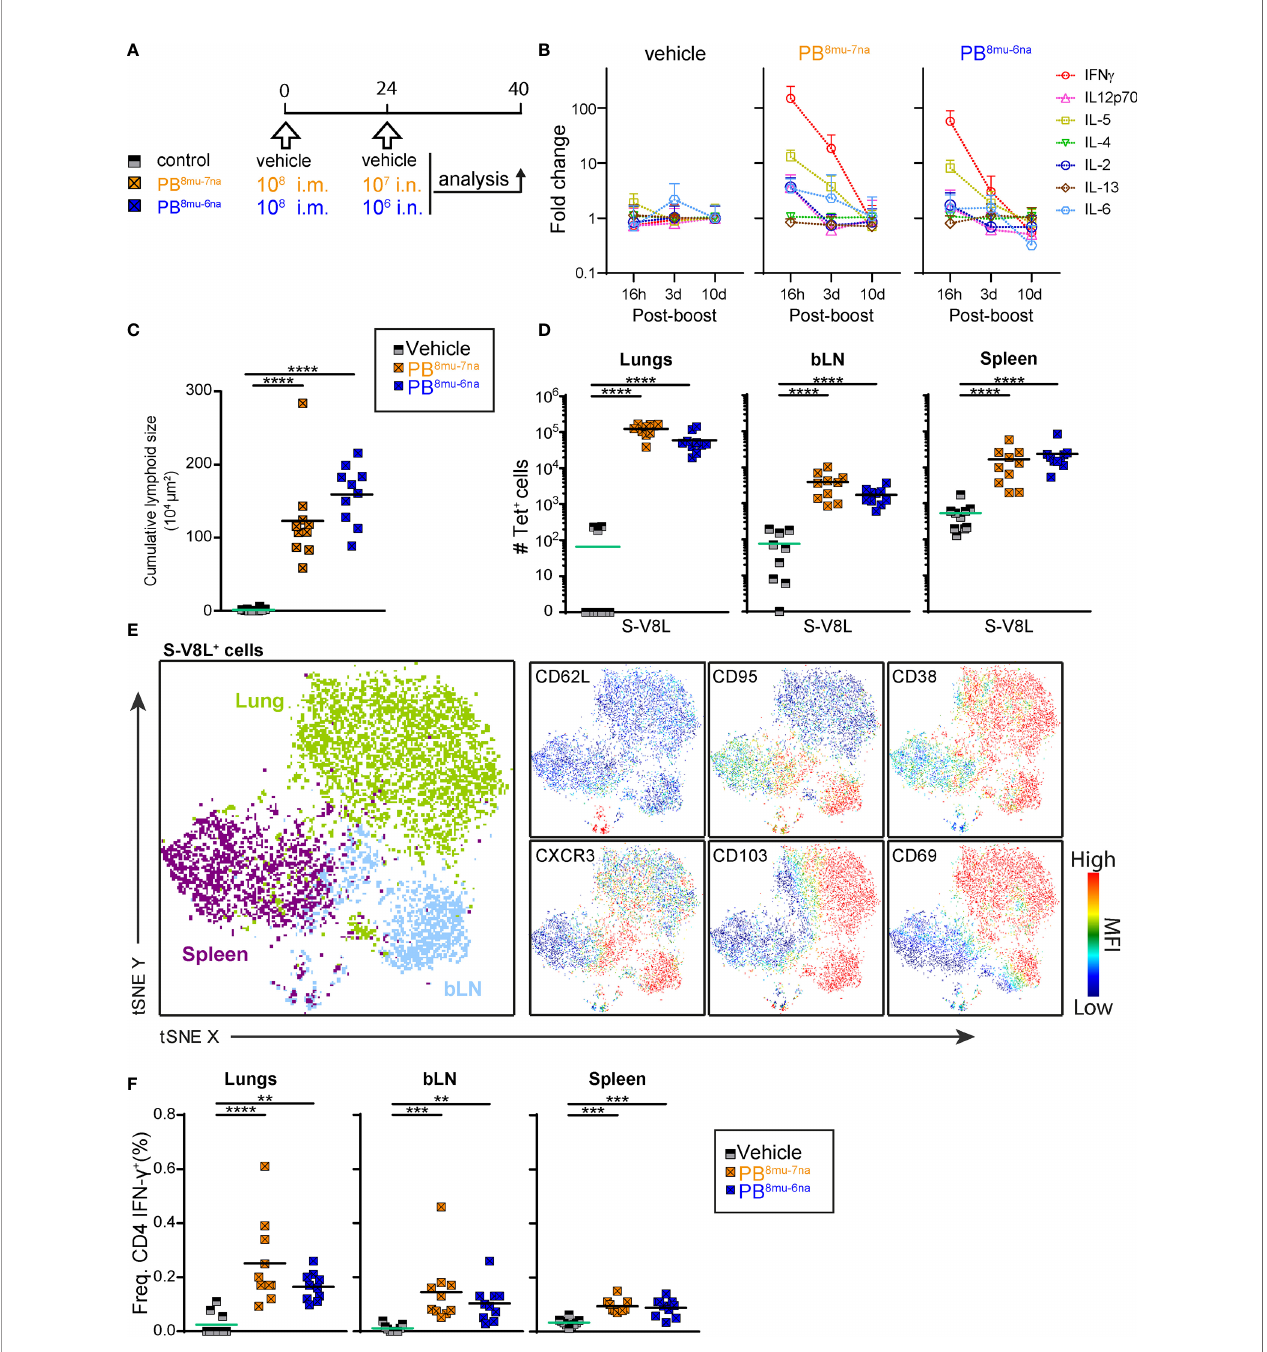
FIGURE 4 | Intramuscular-intranasal prime-boost immunization protocol generates S-speci fi c T cells with tissue resident memory phenotype. (A) Immunization protocol scheme. (B) Relative change of serum cytokine concentrations at times indicated after i.n. boost determined by Ayoxxa ’ s LUNARIS ™ multiplex biomarker platform; cytokine concentrations are given Supplementary Table S4 . (C) Cumulative size of BALT structures averaged from 3-4 central lung sections per mouse. (D) Absolute counts of S-V8L-T + CD44 hi CD8 T cells in different organs of vaccination groups indicated. (E) tSNE plot illustrating CD3 + CD8 + CD44 hi S-V8L-tet + T cells from various organs. Shown are concatenated FCS fi le from each organ indicated of 2 representative mice immunized by the sPB 8mu-7na protocol and analyzed by spectral fl ow cytometry. Colors refer to cells originating from indicated tissues (left, big plot) or to expression levels with red indicating high and blue low expression (6 smaller plots). (F) Frequencies of CD44 hi IFN- g + CD4 T cells analyzed by intracellular cytokine staining after stimulation with the pool of S 1-129 together with immnodominant peptides and brefeldin A ( Supplementary Table S2 ) for 6hr. Pooled data from 2 experiments with n = 6-10 per group. Individual values (signs) and mean group value (line). Statistical analysis was done on log-transformed values using ordinary or Welch ’ s ANOVA followed by Dunnett ’ s T3 multiple comparisons test. **p < 0.01, ***p < 0.001, ****p <